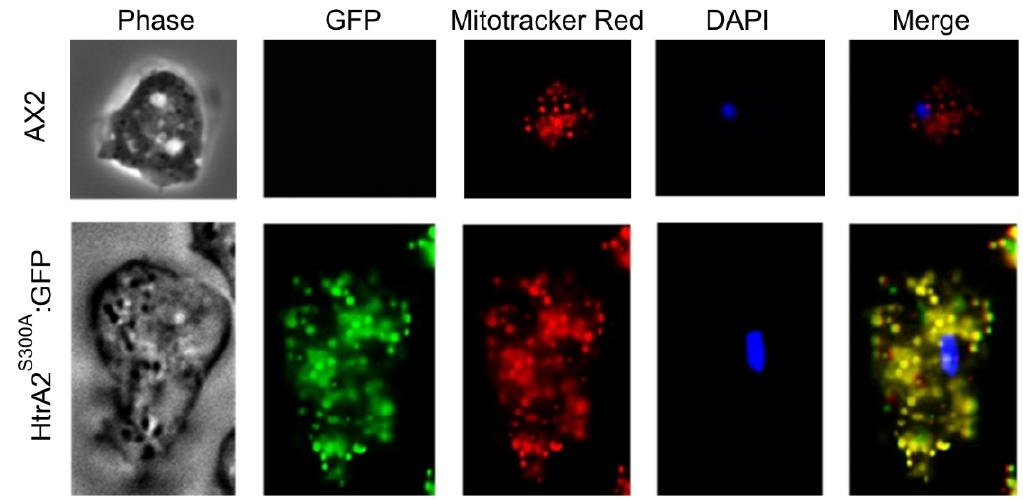
Figure 2. Dictyostelium HTRA2 is located in the mitochondria. The top panels show live AX2 cells and the bottom panels are live transformants expressing HTRA2 S300A :GFP, a GFP-tagged protease-dead mutant form of HTRA2. PH: phase contrast of the D. discoideum cells, DAPI: 4 ′ , 6-diamidino-2- phenylindole, used to stain nuclei, GFP: green fluorescence protein, used to detect HTRA2 S300A :GFP, Mitotracker: Mitotracker Red, used to stain mitochondria, Merge: the overlap of all the images. The differences in size and numbers of stained mitochondria between the wild type and transformed cells are coincidental—both of these features vary significantly from cell to cell even within the same preparation (see examples in